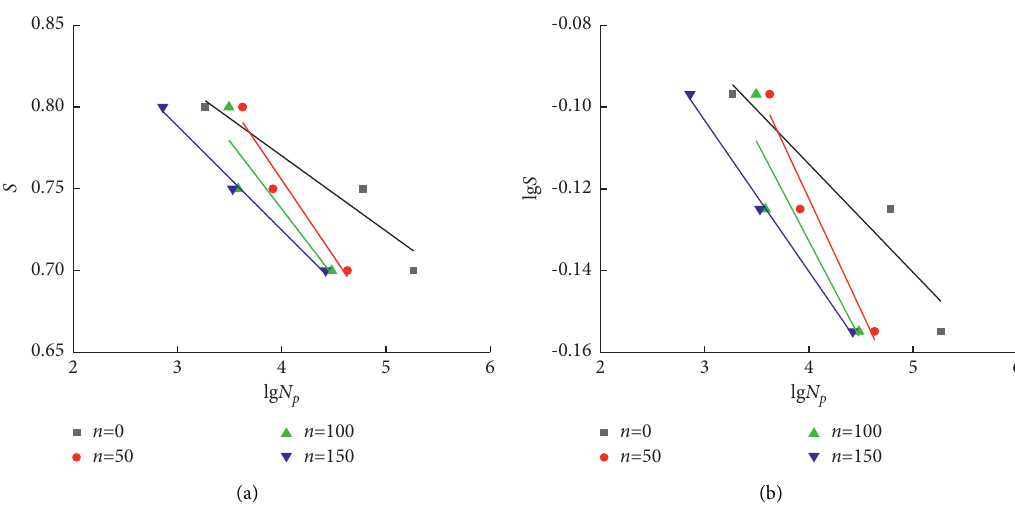
Figure 14: S –lgN and lg S –lgN relationships of AASC with various degrees of frost damage at P f � 0 . p p